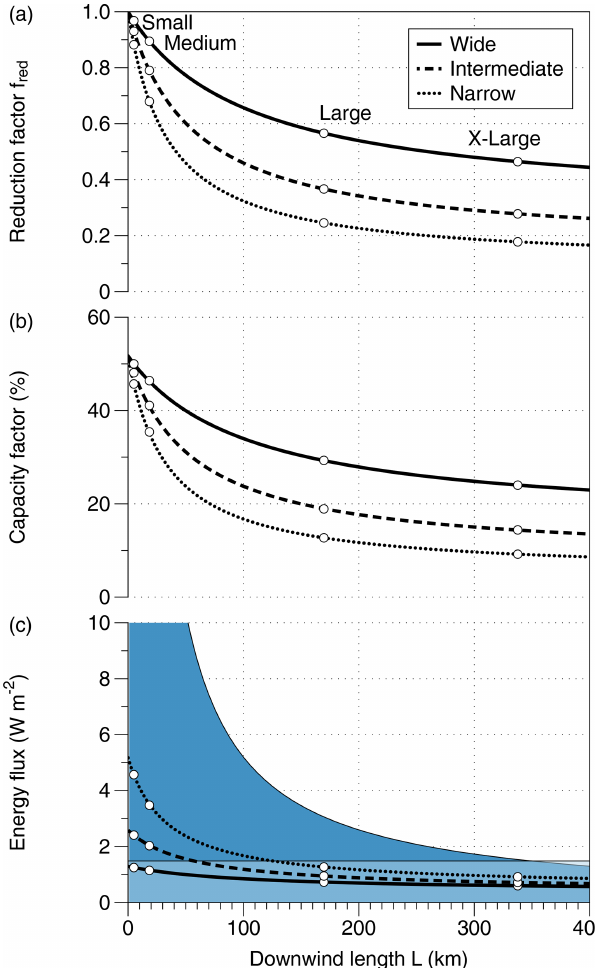
Figure 6. KEBA sensitivity to downwind length L for region B (North Sea). The panels show (a) the KEBA reduction factor f red as a function of downwind length for three turbine spacings, (b) the associated reduction in capacity factor ( P el /NP el , max ), and (c) the supply of kinetic energy by the horizontal influx from upwind areas (dark blue) and by vertical mixing (light blue) as well as the yields by the wind farms (lines). The circles represent the different sizes of wind farms considered in the comparison with Volker et al.